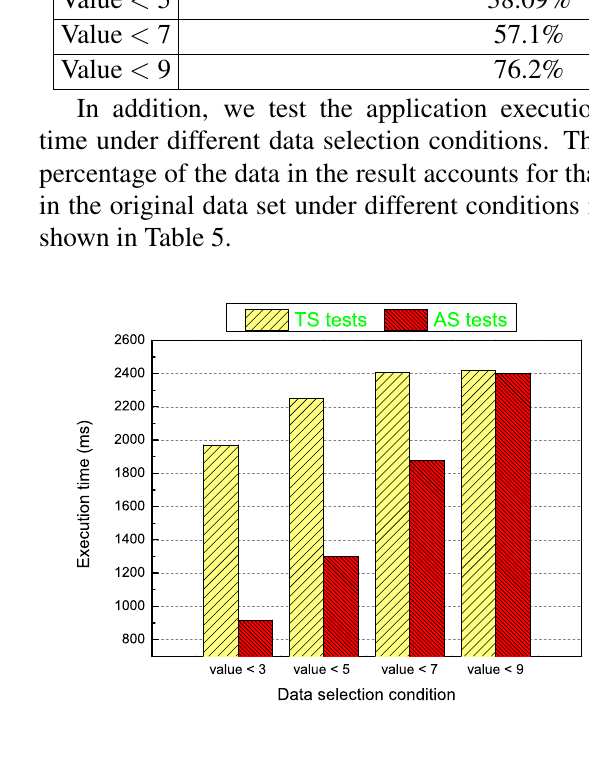
Fig. 5. Application performance under different